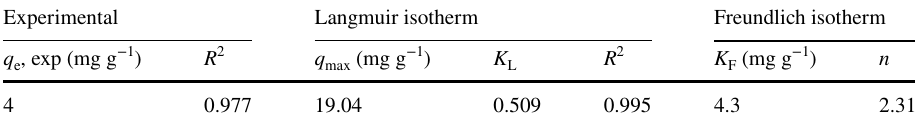
Table 1 Kinetic parameter values of adsorption kinetics for MB onto mesoporous silicalite-1